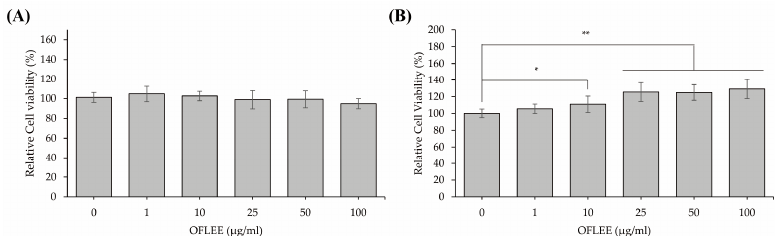
Figure 1. OFLEE does not induce cell death in either L929 fibroblast cells used as normal cells or BMMs. ( A ) OFLEE did not affect the viability of L929 fibroblast cells. ( B ) Quantities of 10–100 µ g/mL OFLEE increase the viability of BMMs. Both mouse embryonic fibroblast L929 cells used as normal cells to measure the cytotoxicity and BMMs were cultured at a density of 0.5 × 10 5 cells/mL in a 96-well culture plate for 24 h and were treated with 1, 10, 25, 50 and 100 µ g/mL OFLEE for 24 h. Thereafter, MTT assay was performed to measure the cytotoxicity of OFLEE in L929 fibroblast cells and BMMs. Results are mean ± SD of three independent experiments ( n = 3), * p < 0.05 and ** p <